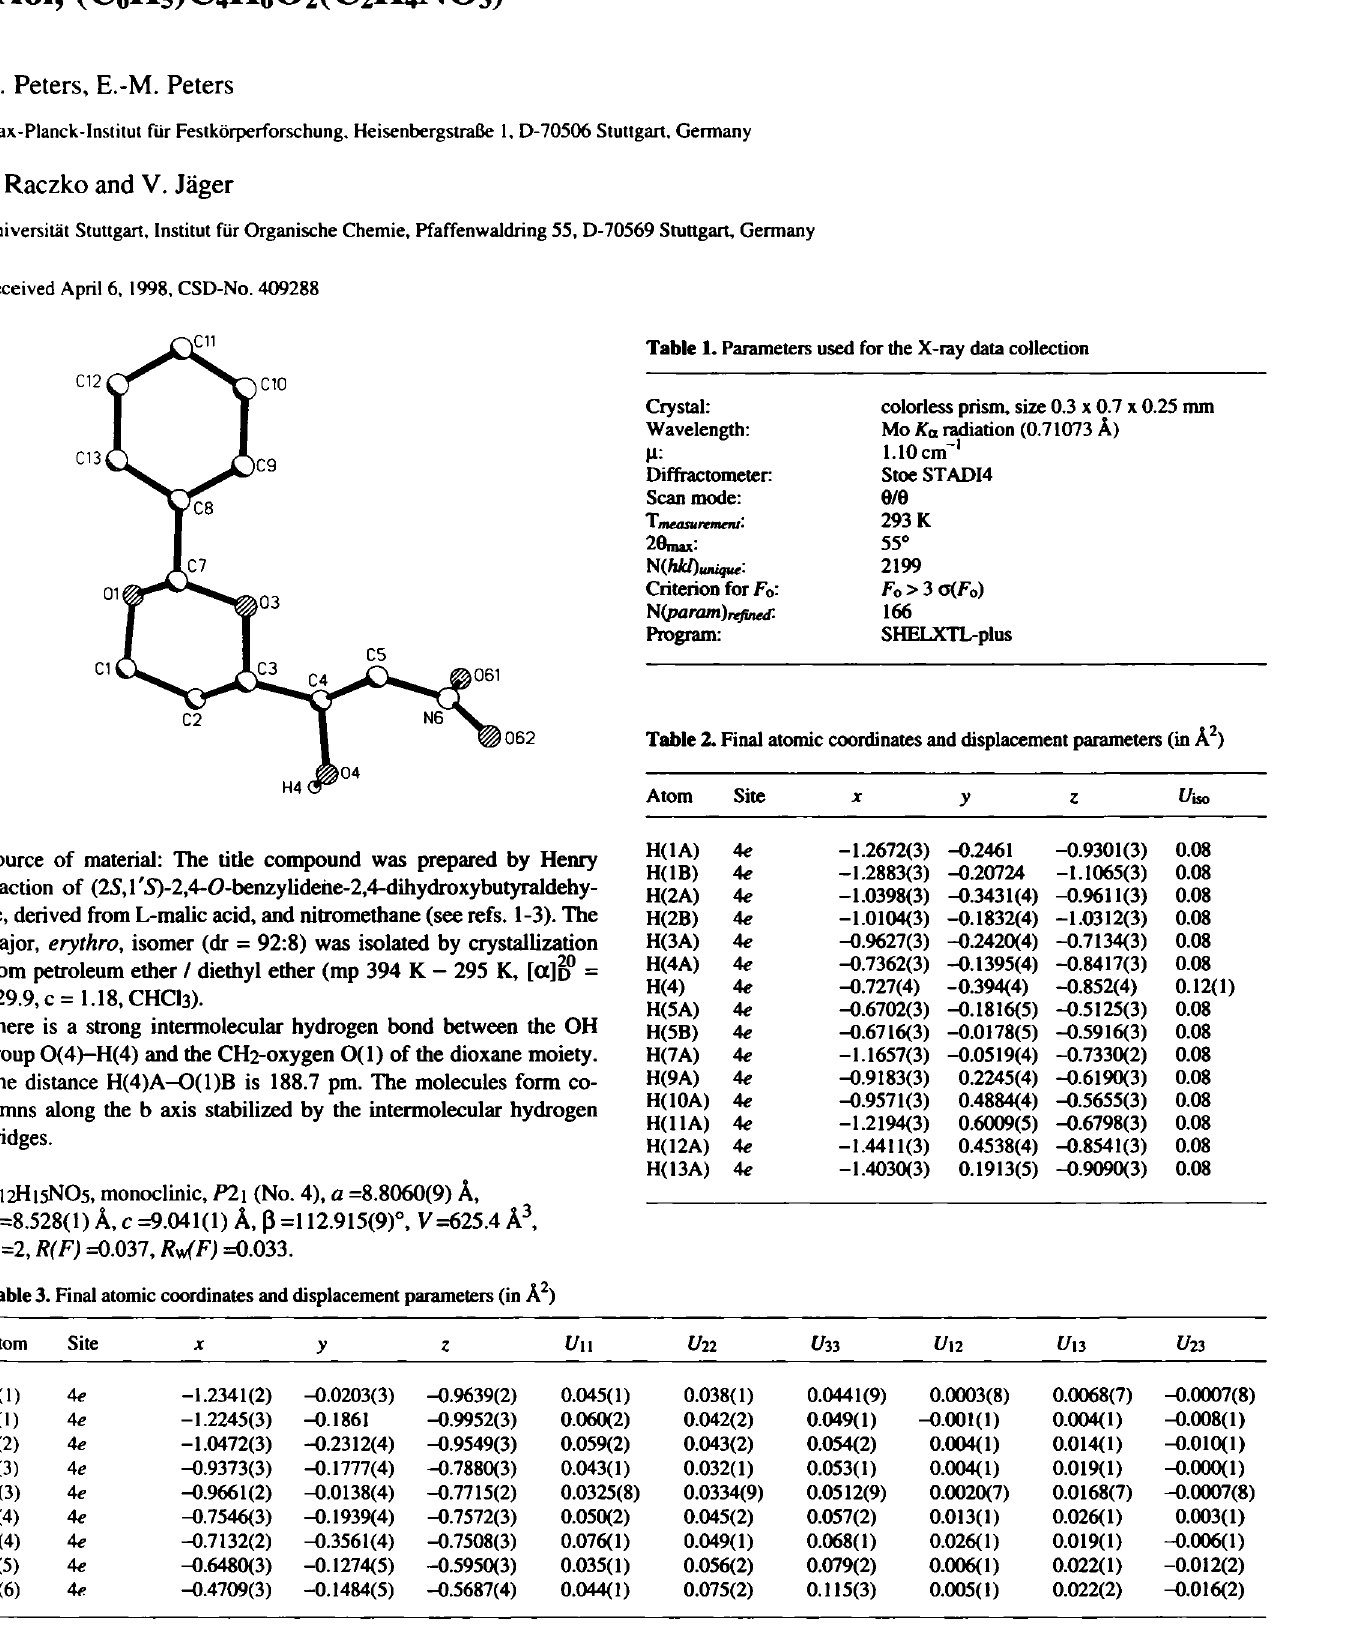
Table 1. Parameters used for the X-ray data collection Crystal: